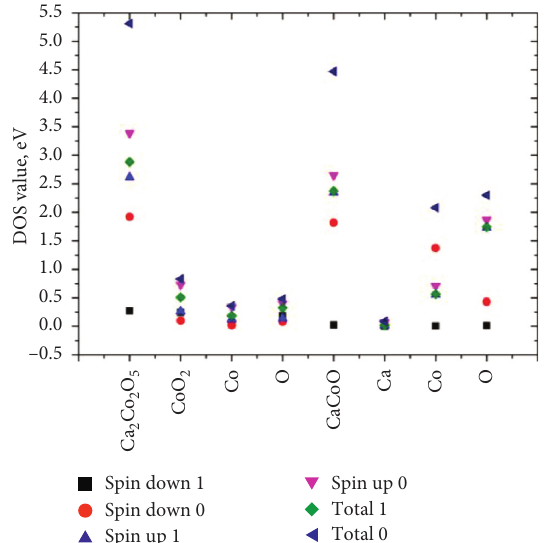
Figure 9: Densities of state values on the Fermi level of the sandwiched Ca